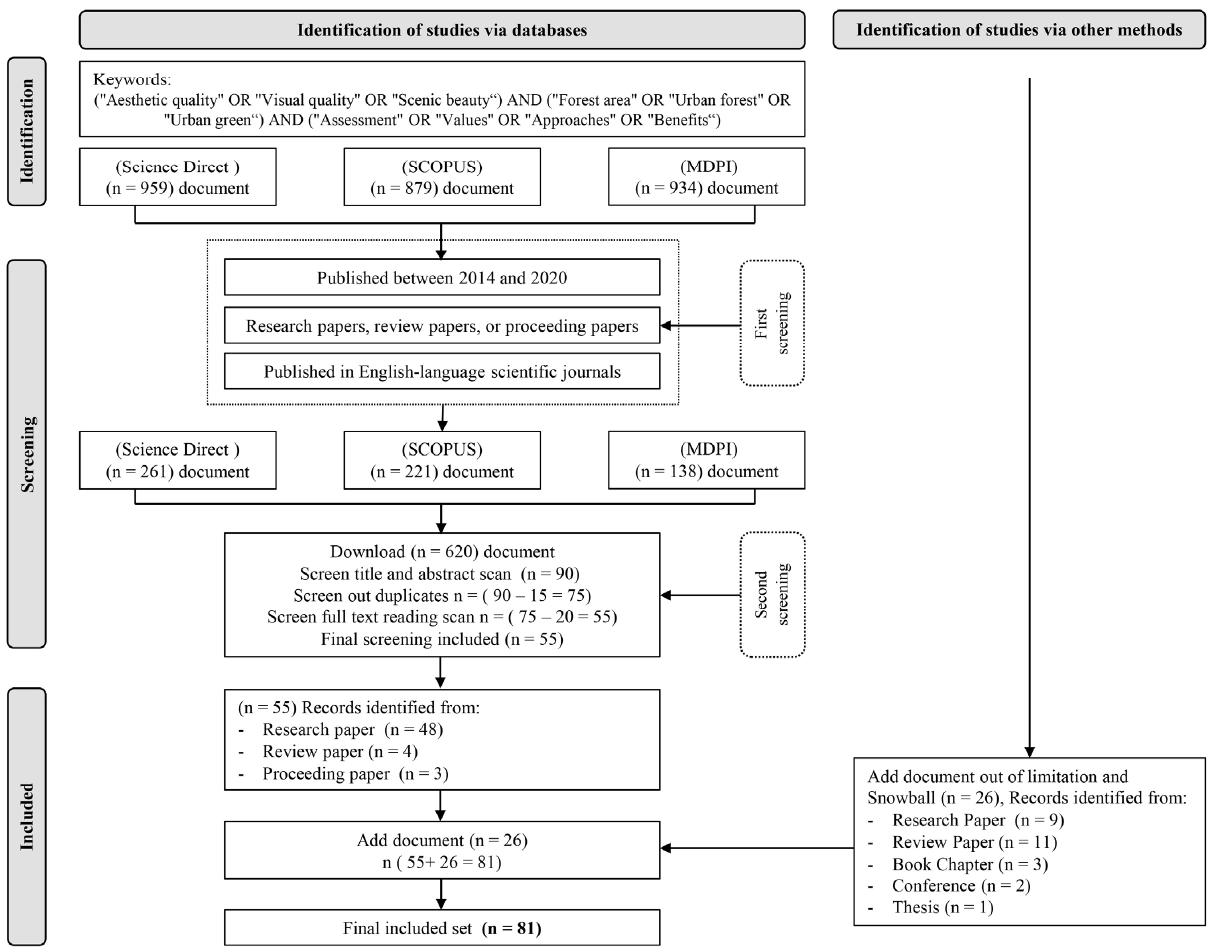
Figure 1. Document flow diagram summarizing the search findings and the screening process used in the systematic review.